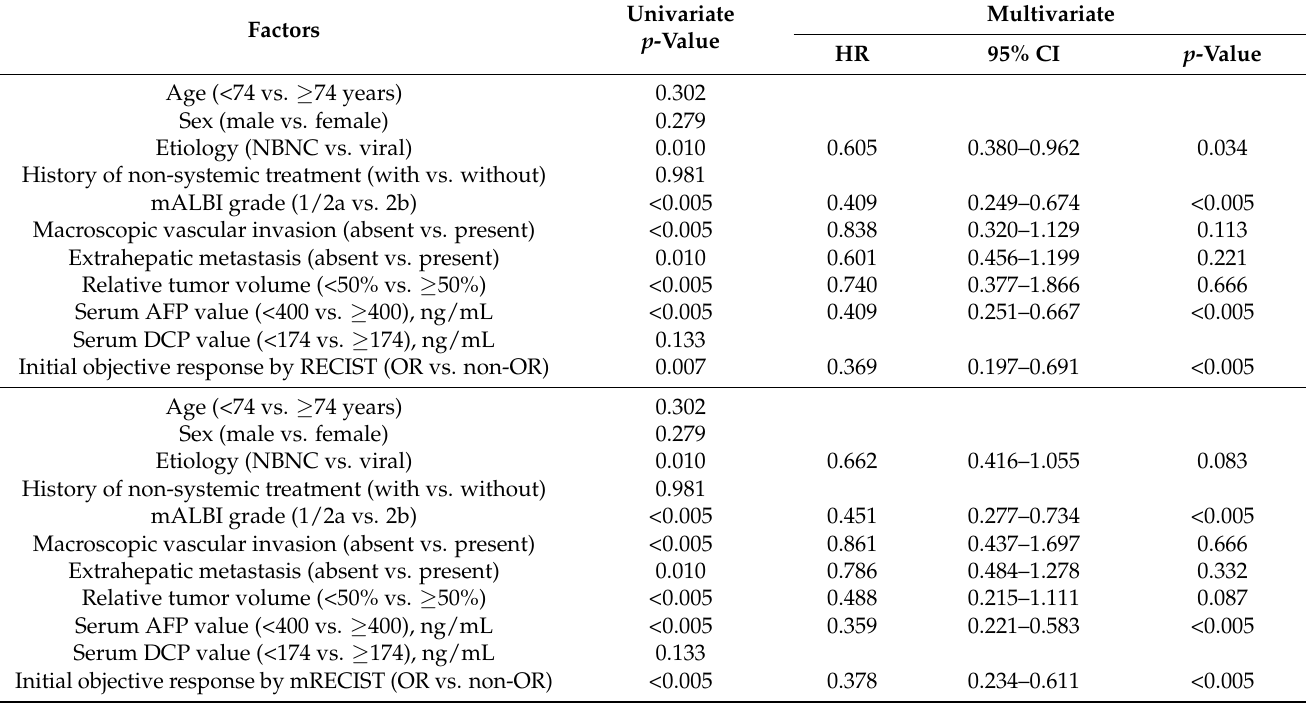
Table 3. Univariate and multivariate analyses of prognostic factors for overall survival.